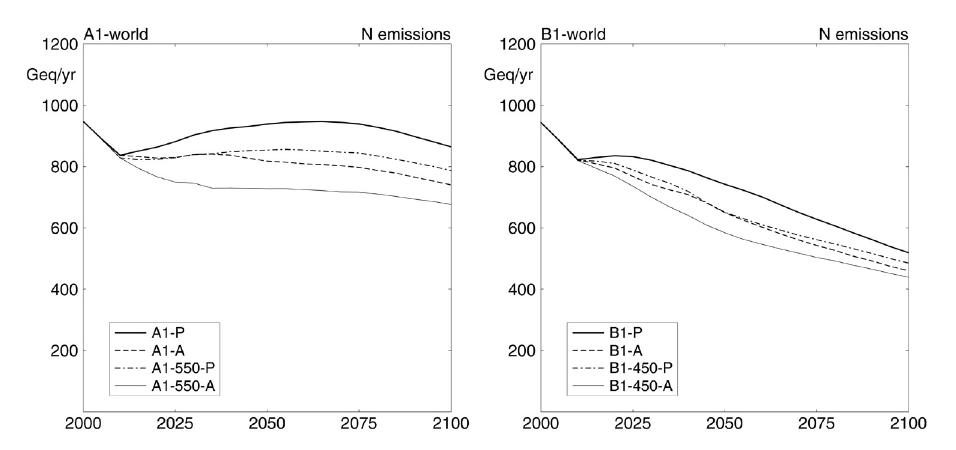
FIGURE 4. Temporal development (2000–2100) of the total European nitrogen emissions for the four scenarios each in the A1-world (left) and the B1-world (right) (1 Geq=14